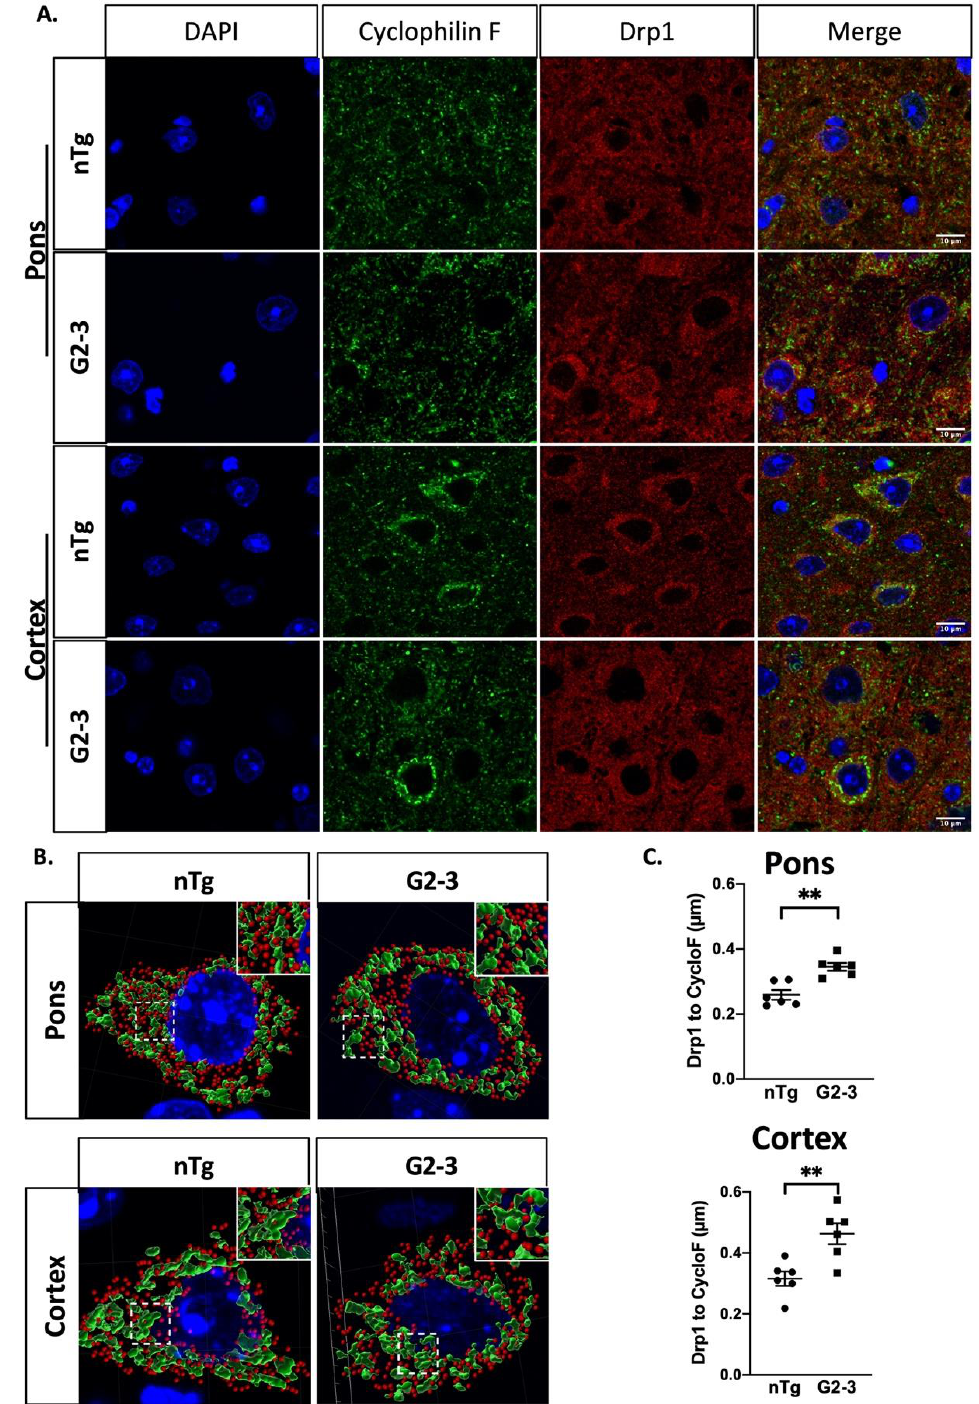
Figure 2. Mutant αS expression is associated with reduced Drp1 colocalization to mitochondria in vivo. ( A ) Immunofluorescent confocal imaging of mitochondria (Cyclophilin F) and Drp1 in mouse brains from nTg and TgA53TG2-3 (G2-3) mice. ( B ) Rendering of the 3D-reconstructed immunofluorescence signal in a representative neuron from the nTg (pons) and G2-3 (pons and cortex). ( C ) Quantifications of mean minimal distance between Drp1 and Cyclophilin F (Cyclo F) (mean ± SEM of means from each subject) show that in G2-3 mice, the mean minimal distance is increased by about 30%, and about 50% in the pons and cortex, respectively ( p = 0.0013, p = 0.0066). An unpaired t -test with Welch’s correction ( n = 6 per group) was performed. (** p < 0.01).